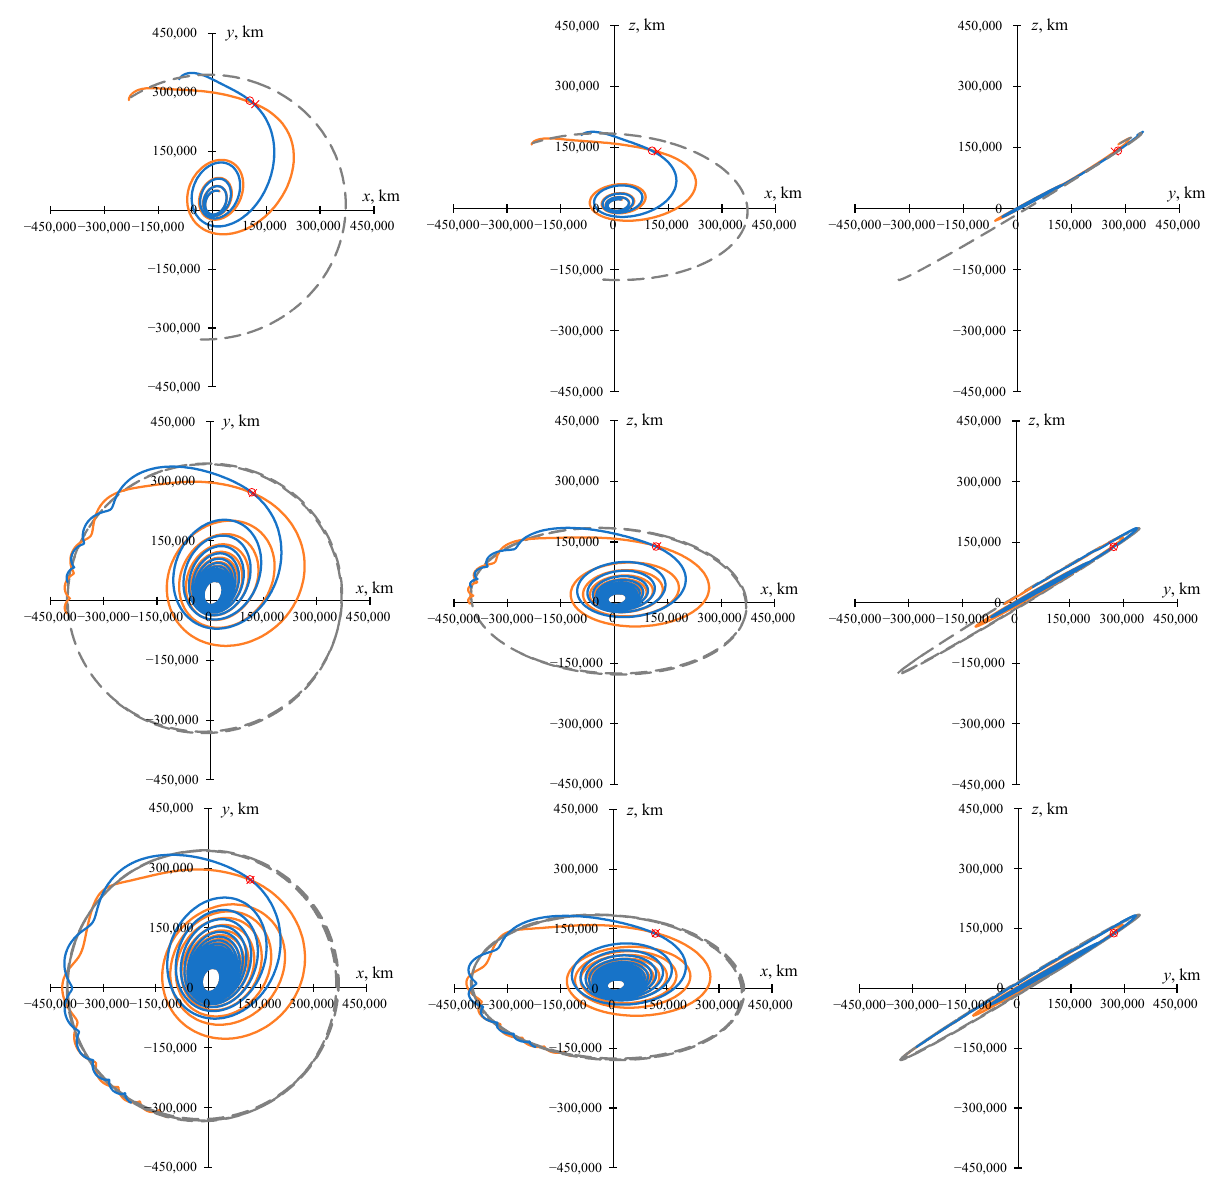
Figure 1. The projection of the optimal 5-(upper row), 20-(middle row), and 35-(lower row) revolu- tion trajectories with an optimal junction point and with an intermediate EML 1 rendezvous in the inertial coordinate system J2000.